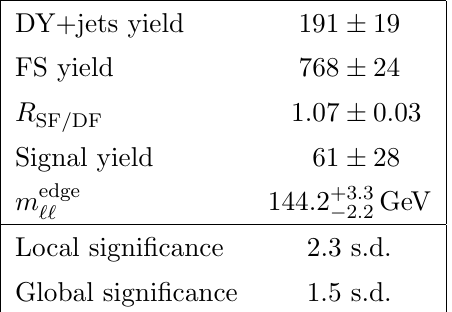
Table 4 . Predicted and observed yields in each bin of the edge search counting experiment. The uncertainties shown include both statistical and systematic sources.